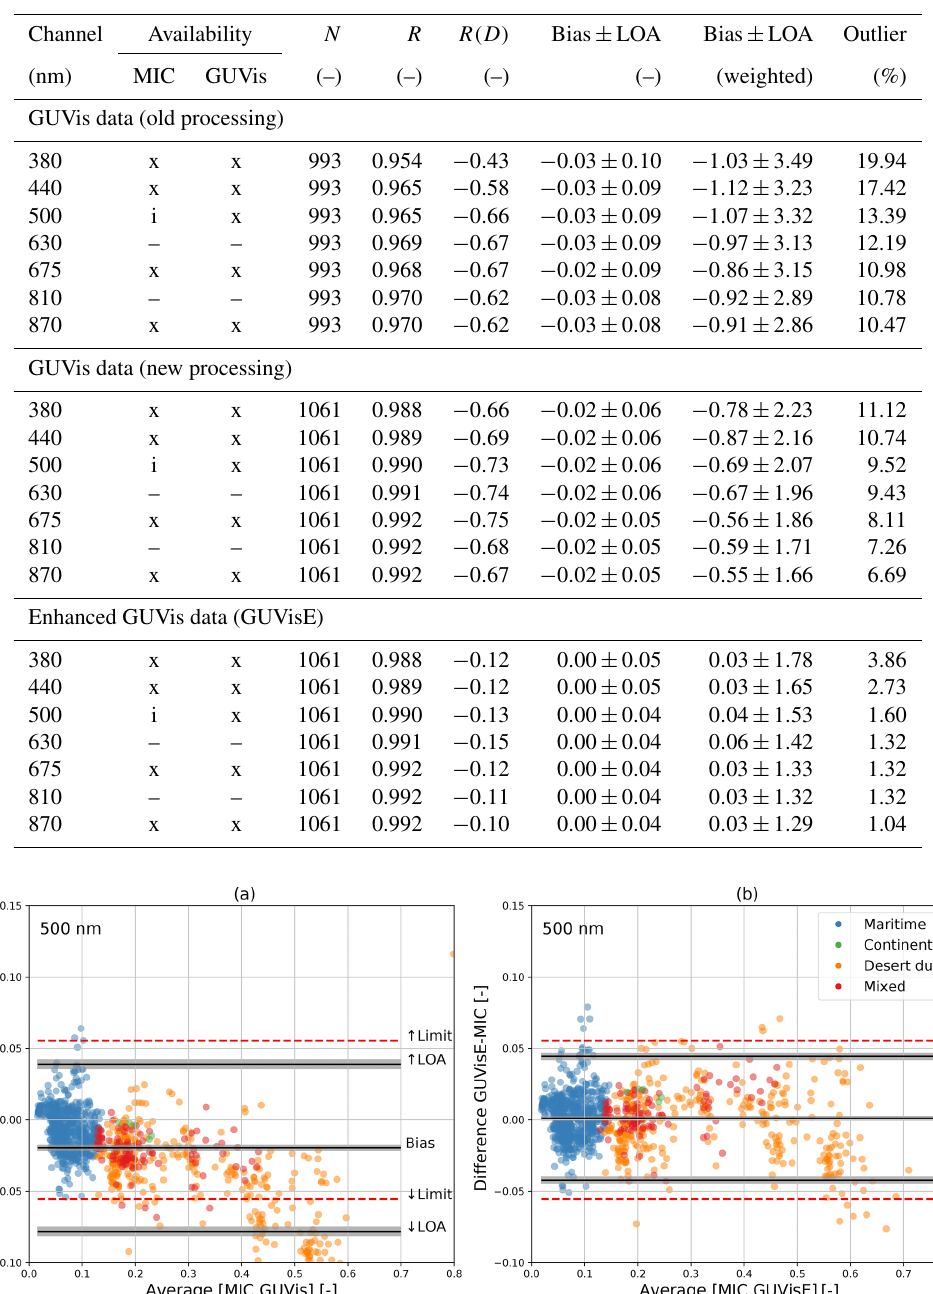
Table 4. Statistics comparing the old and new processing algorithms of the GUVis observations, as well as the calibration- and forward- scattering-corrected GUVis dataset versus the MIC dataset. Availability of Microtops and GUVis channels is indicated as follows: x:available; i:internally interpolated; –:interpolated using AE. Statistics include the number of data points ( N ), Pearson correlation coefficient ( R ), the Pearson correlation coefficient of difference ( R(D) ), and bias plus fraction of outliers based on the limit of agreement (LOA) method for 95% confidence interval (see Sect. 3.3 for explanation of R(D) , bias and LOA).